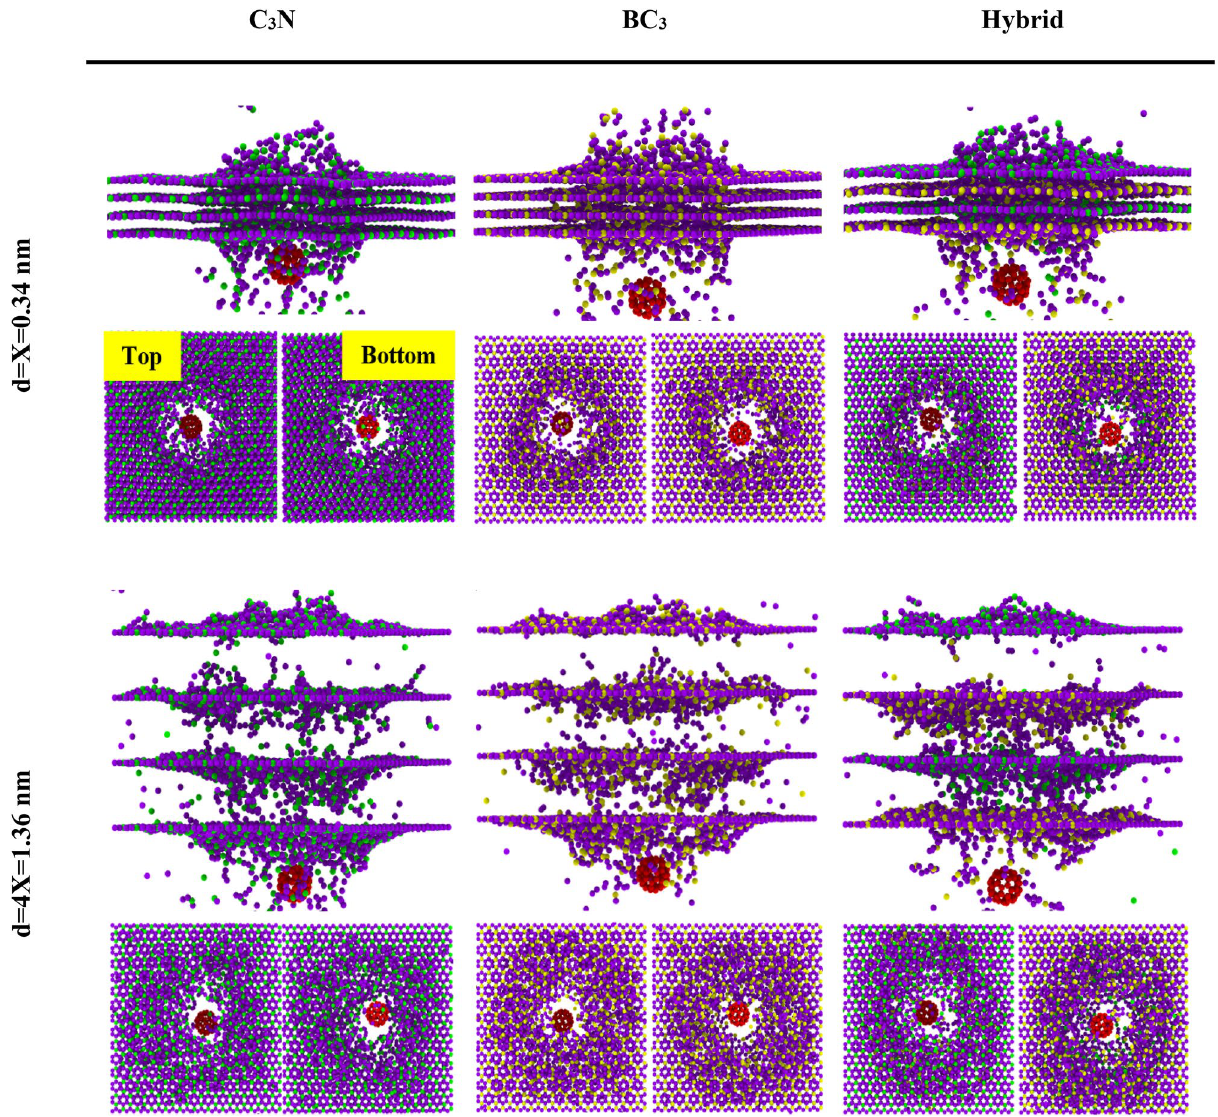
Figure 4. Image of configurations created after the C 60 impact on four-layer stacks of the C 3 N, BC 3, and C 3 N-BC 3 hybrid nanosheets with K 0 = 15,393.19 eV for different layer spacing including d = X = 0.34 and d = 4X = 1.36